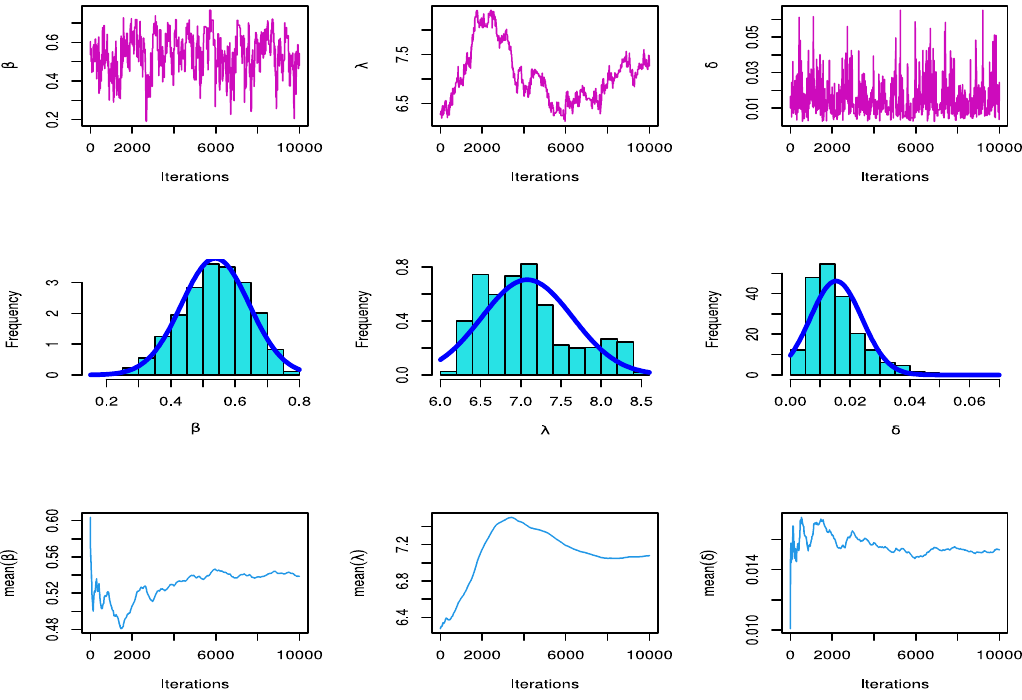
Figure 3. The MCMC plots for data based on PTIICS.